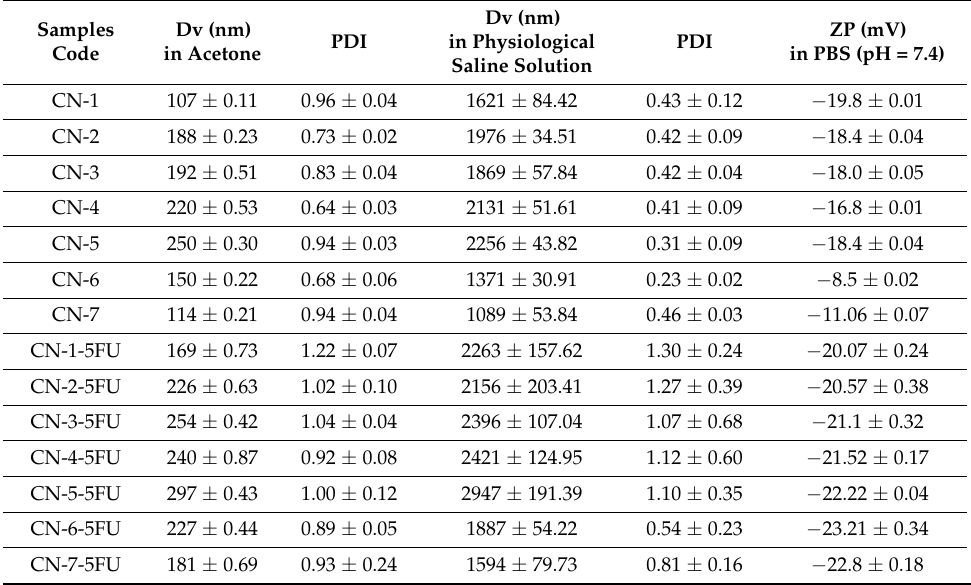
Table 3. Diameter in volume, polydispersity index (PDI), and Zeta potential values of NCs samples. Samples